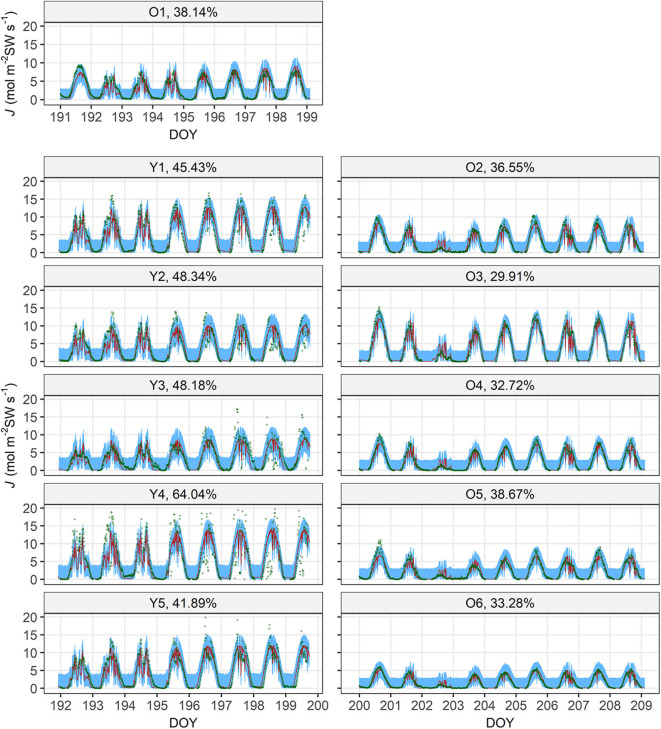
Measured sap flow density (J(O), dark green circle) and 95% intervals of parametric (λ, ι, γ, ρ and χ; red shade) and measurement (blue shade) uncertainties of modelled sap flow density (J(M)) of the sample trees. Each panel is titled with the tree's number (Table 1) and normalized root-mean-square error (RMSE%) by the mean of respective J(O). For visual clarity, the J(M) values with the maxima a posteriori (MAP) estimates of the parameter vectors are not shown because the parametric uncertainty is very small. DOY, day of year (marked at 00:00 of the day).